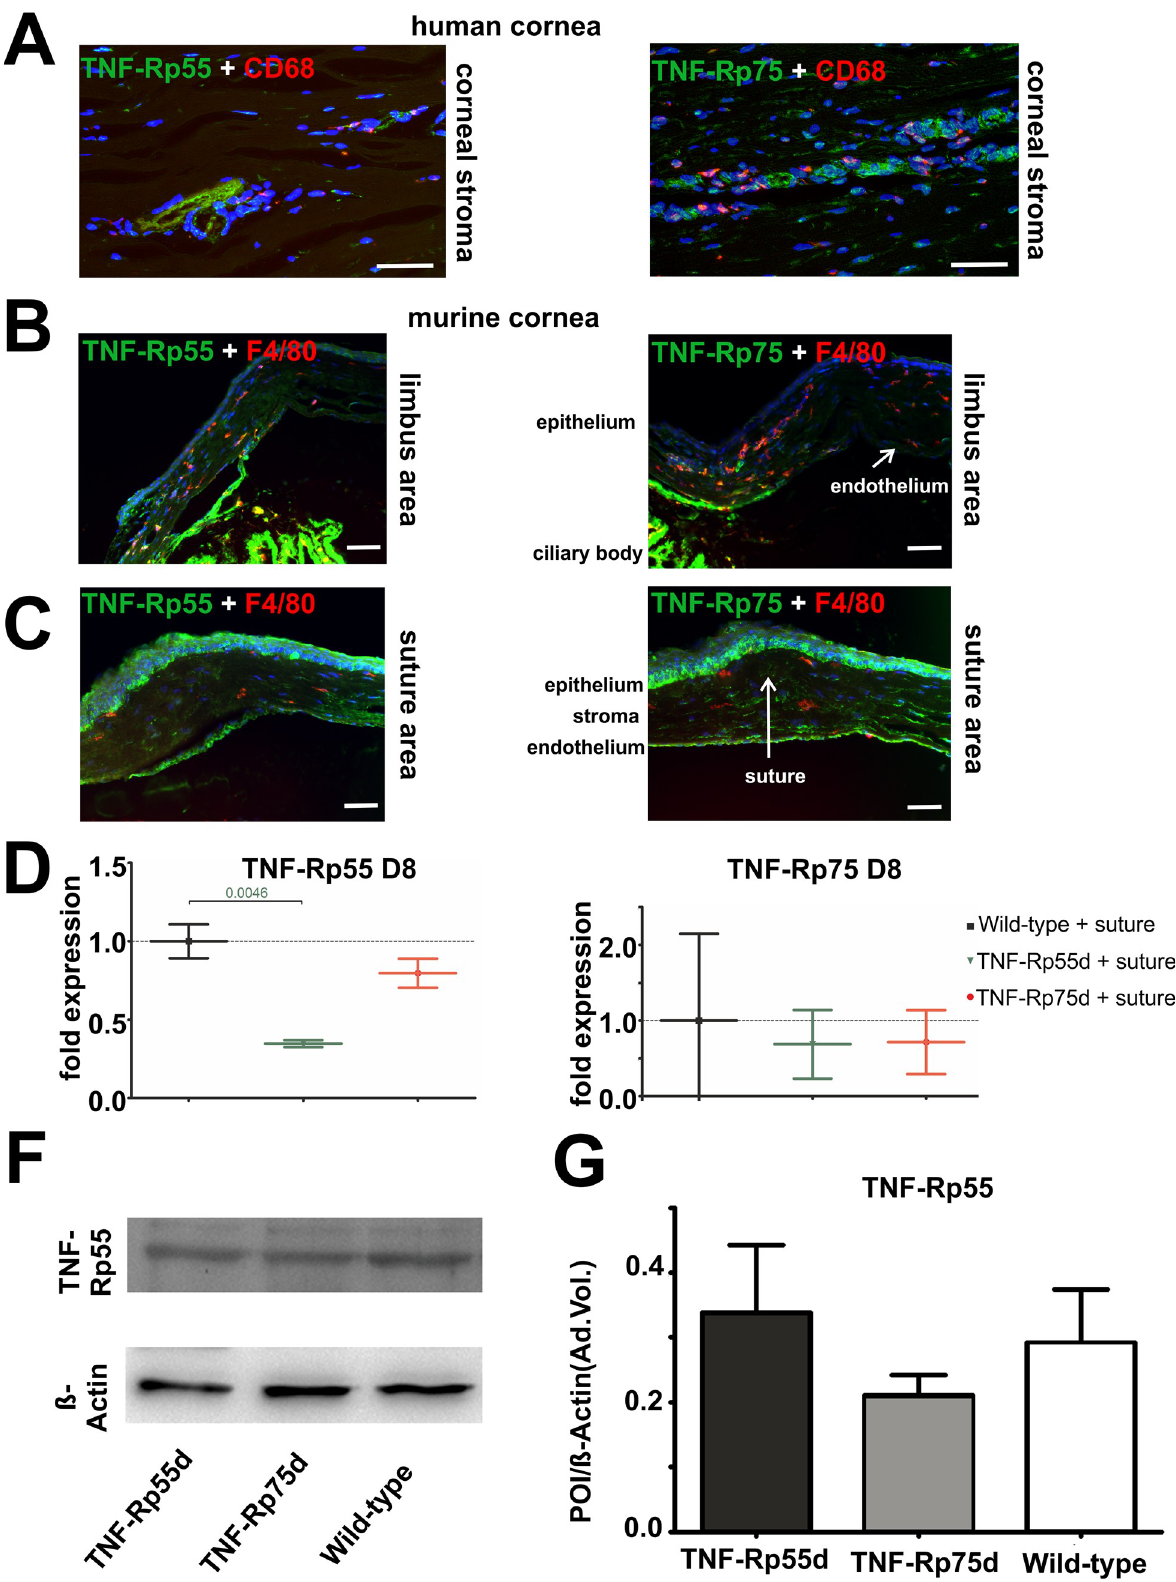
Fig 1. TNF-Rp55 and TNF-Rp75 expression in human and in murine cornea. A: Sagittal sections of vascularized human cornea stained with antibodies against TNF-Rp55 and TNF-Rp75 (green), and CD68 (red). Nuclei are stained with DAPI. Images display the stroma of human